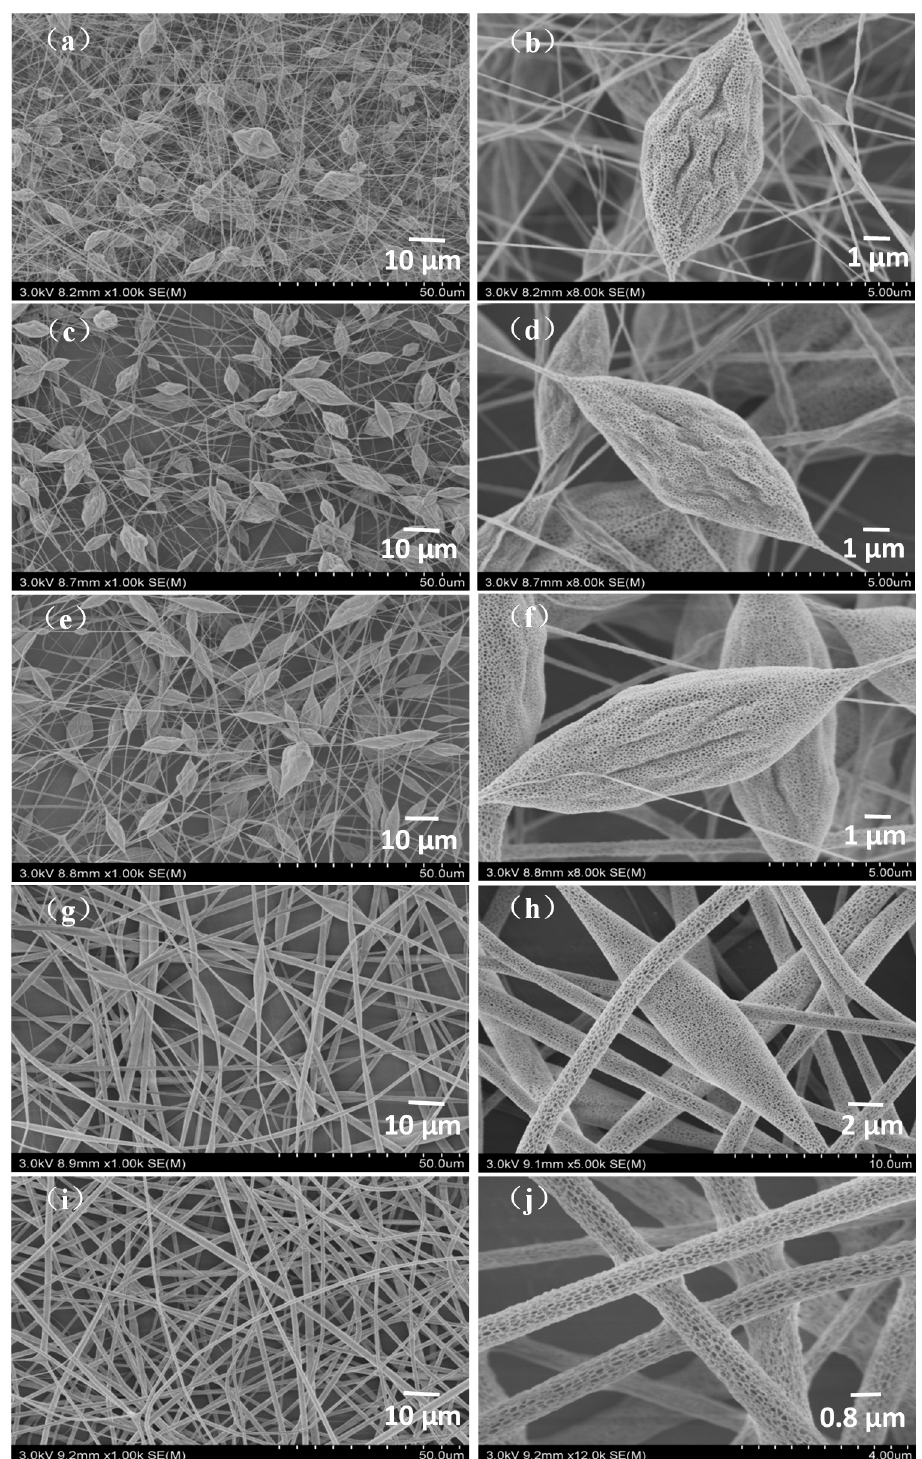
Figure 1. FE-SEM images of the PLA/chitosan fibrous membranes prepared at different concentrations: ( a , b ) 4 wt % PLA, 1 wt % CS; ( c , d ) 5 wt % PLA, 1.25 wt % CS; ( e , f ) 6 wt % PLA, 1.5 wt % CS; ( g , h ) 7 wt % PLA, 1.75 wt % CS; and ( i , j ) 8 wt % PLA, 2 wt % CS.